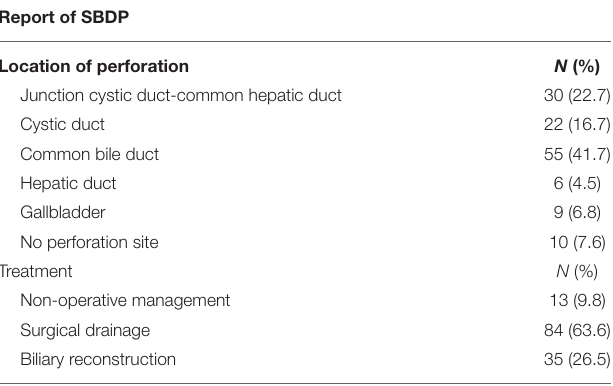
TABLE 3 | Location of biliary perforation in reported 132 cases. Report of